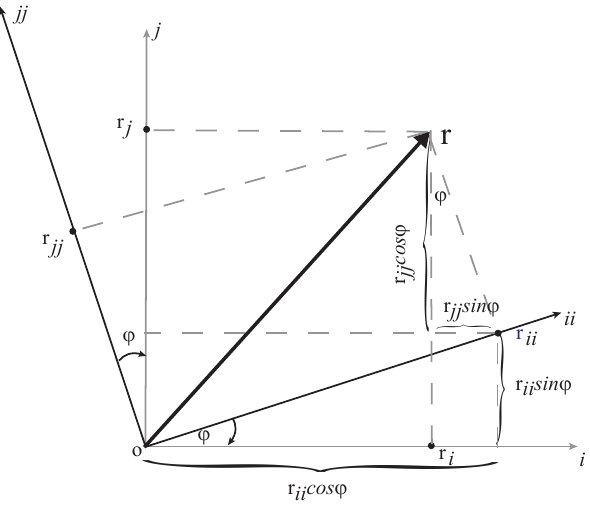
Fig. 4. Clockwise rotation of an arbitrary right hand 2-dimensional coordinate